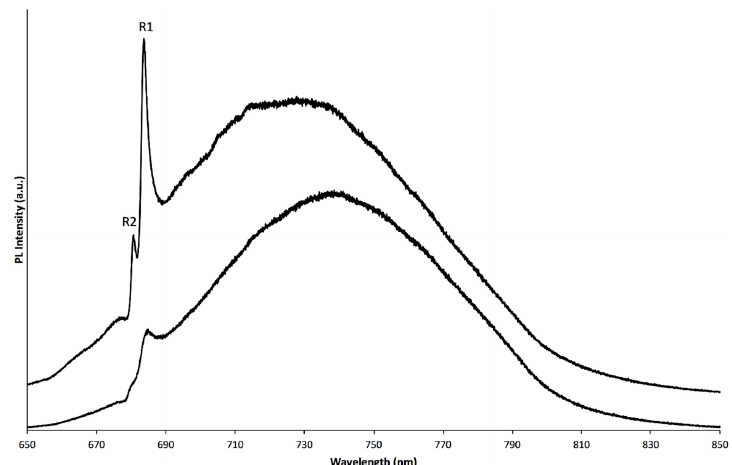
Figure 25. PL spectra from 650 to 850 nm of an emerald from Colombia (upper spectrum) and an emerald from Zimbabwe (bottom spectrum). Note that the upper spectrum is shifted higher for clarity.